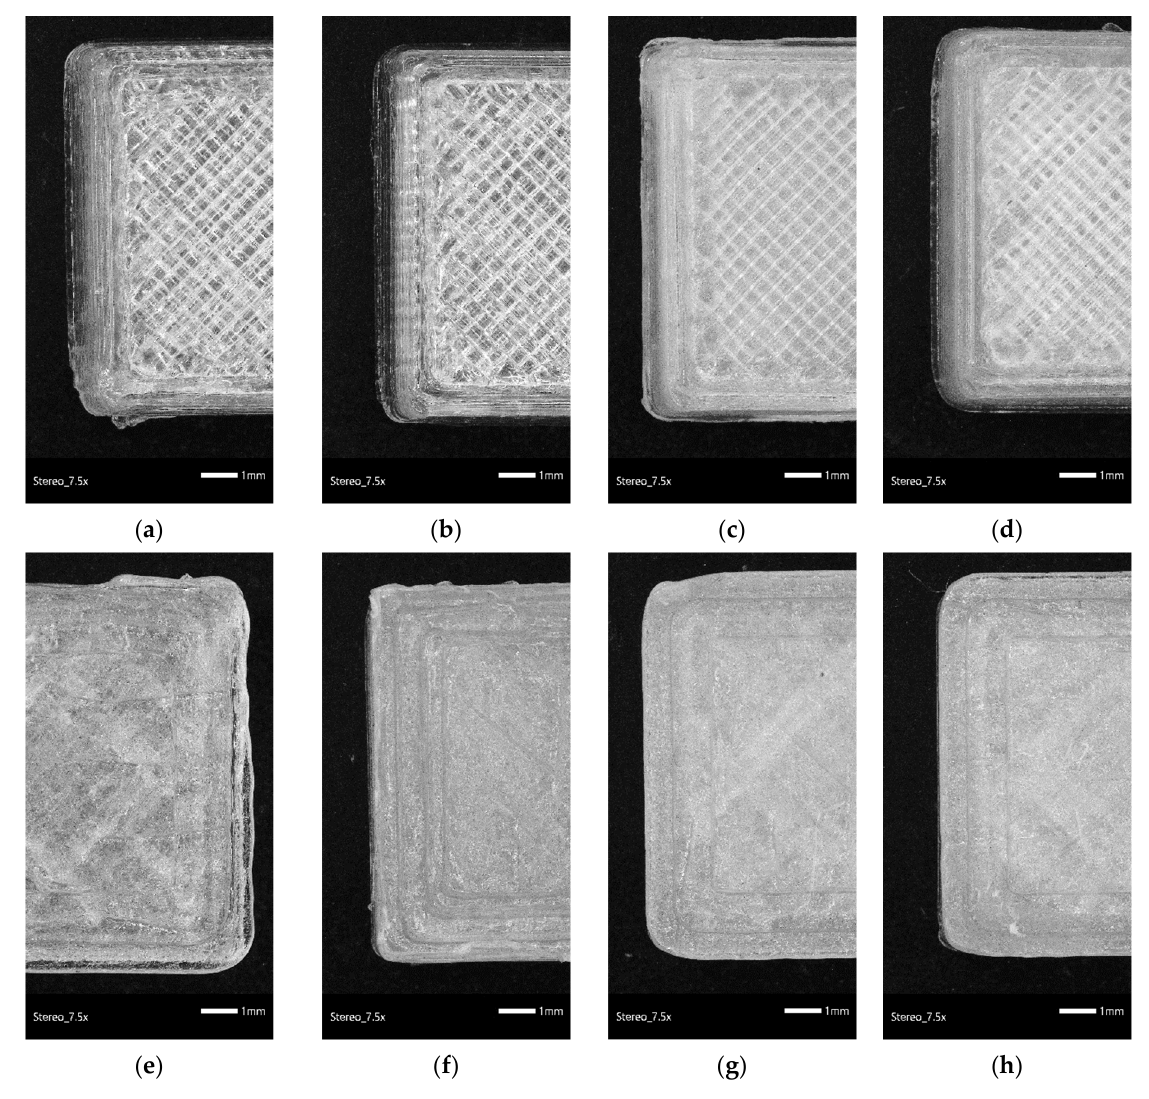
Figure 2. Stereoscope images of ( a ) PLA top view, ( b ) PLA/MMT1 top view, ( c ) PLA/MMT2 top view, ( d ) PLA/MMT4 top view and ( e ) PLA bottom view, ( f ) PLA/MMT1 bottom view, ( g ) PLA/MMT2 bottom view, ( h ) PLA/MMT4 bottom view of 3D-printed specimens through FFF technology. Table 5. Energy spectrum analysis of SEM